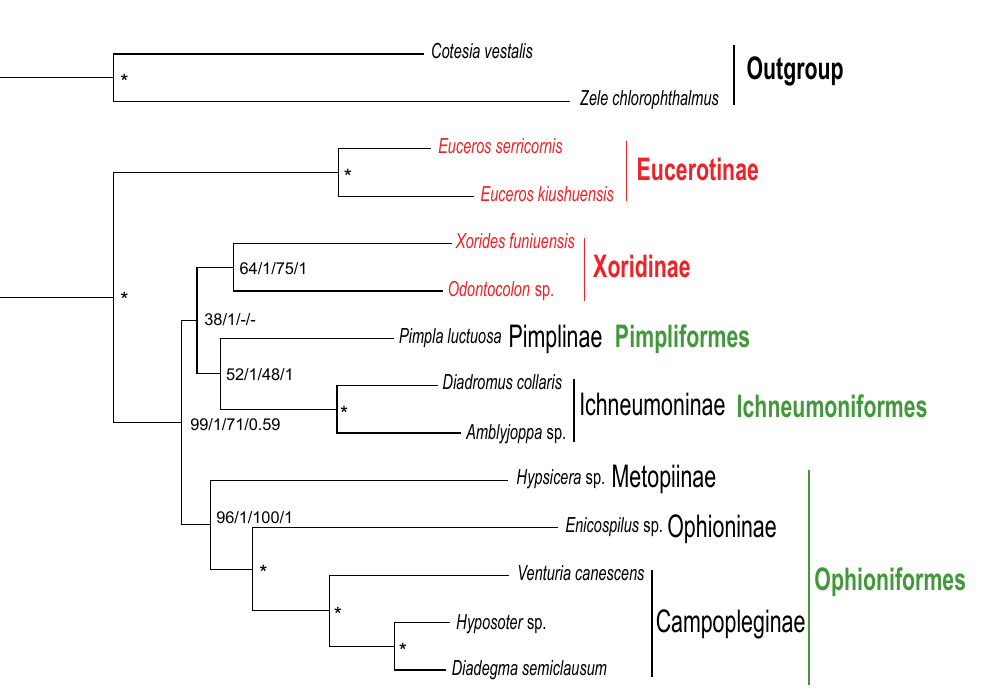
Figure 4. Phylogenetic relationships of family Ichneumonidae inferred from datasets nucleotides (NU) and amino acids (AA) sequences of 13 protein-coding genes in mitochondrial genomes using BI and ML methods. Zele chlorophthalmus and Cotesia vestalis from Braconidae were employed as outgroup. The numbers separated by “/” indicate the posterior probability (PP) and bootstrap values (BS) of the corresponding nodes from left to right: PP of NU, BS of NU, PP of AA, BS of AA. “*” indicates that the node was fully supported by all four inferences.